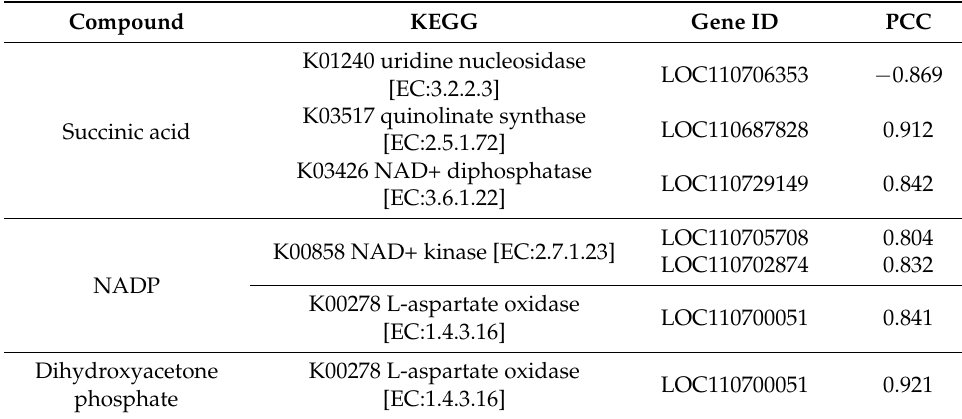
Table 4. Key substance and gene correlation